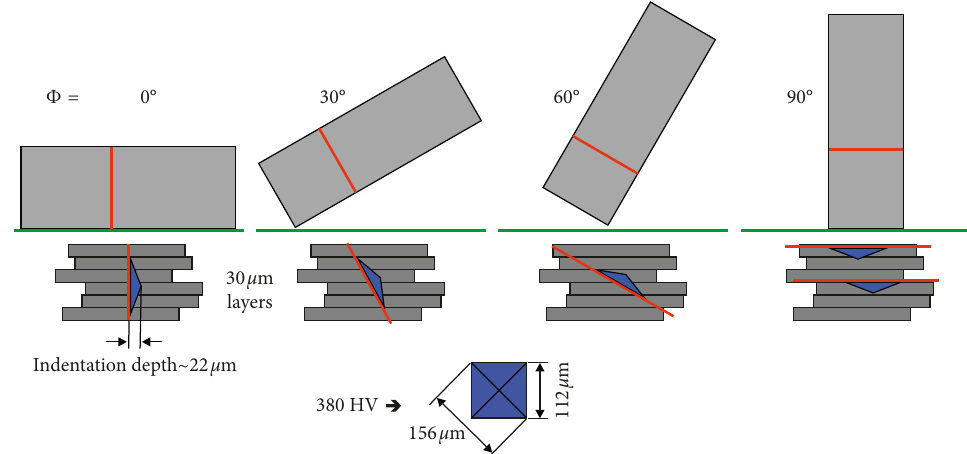
Figure 13: Indentation depth versus layer